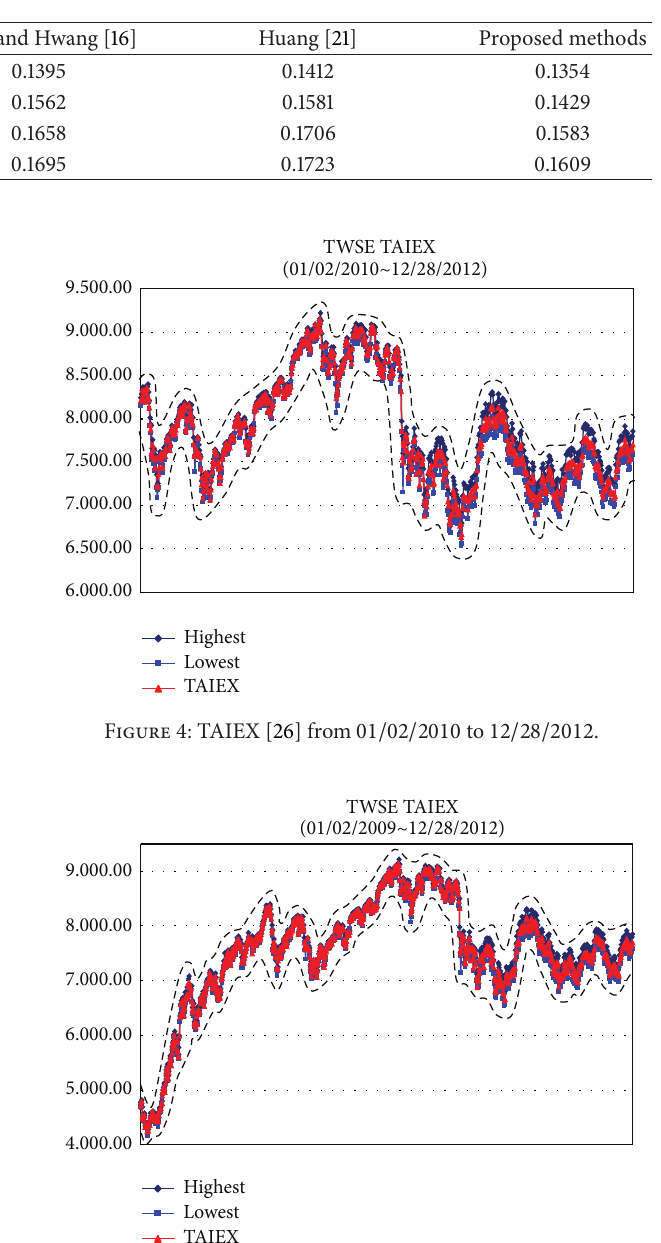
Table 1: Comparison results of the measure of fitness.